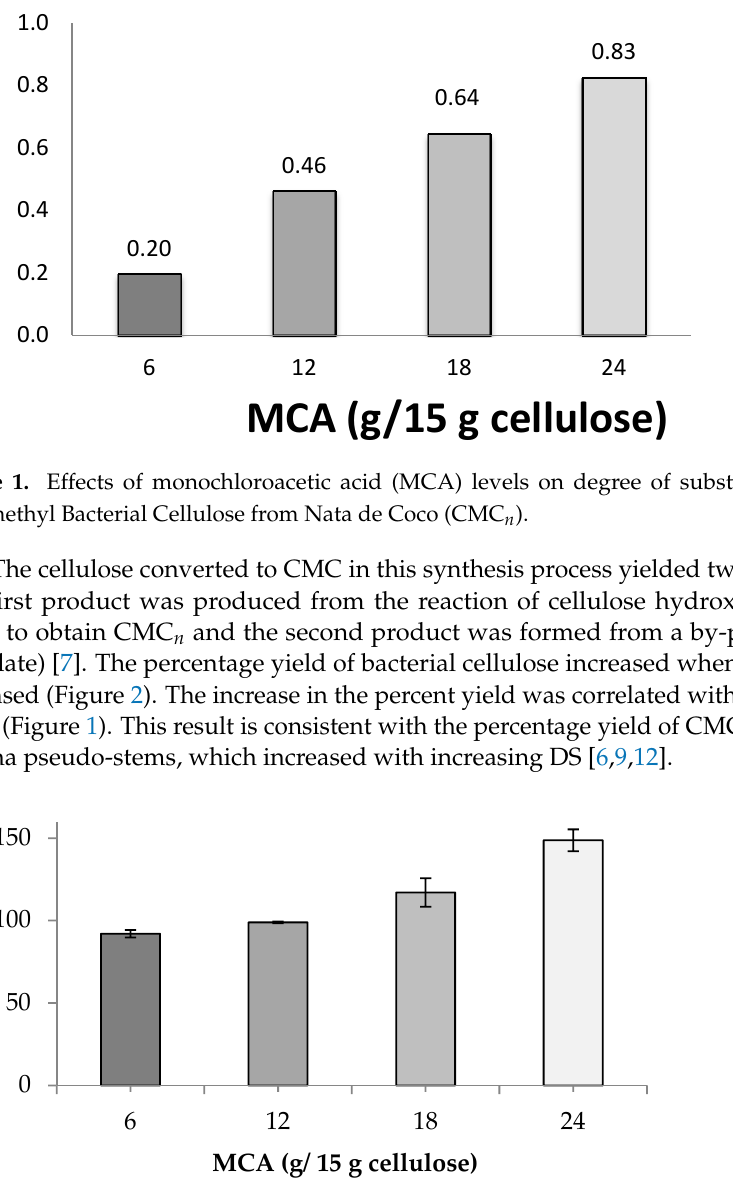
Figure 2. Effects of MCA levels on the percent yield of CMC n .